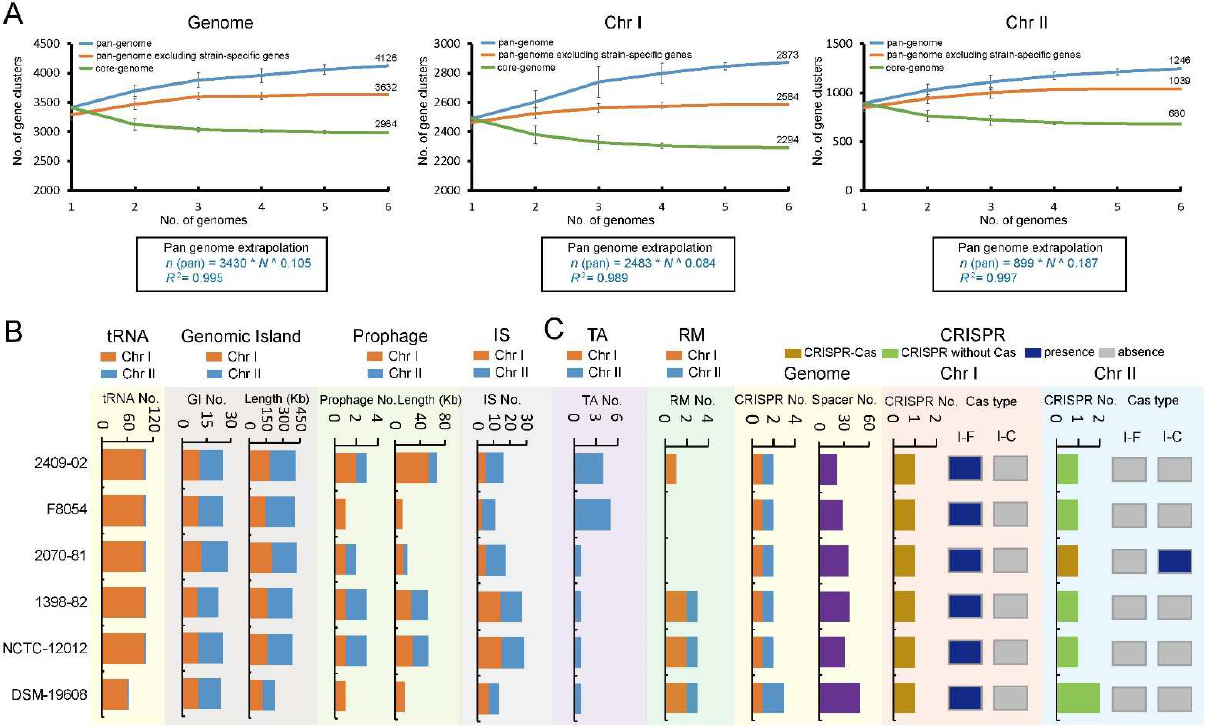
Figure 2. ( A ) The progressive curves for the core, pan-genome, and pan-genome excluding strain- specific genes of the V. cincinnatiensis genome, Chr I, and Chr II. The curves showed the downward trend of the core gene families and the upward trend of the pan-gene families with additional genomes. The deduced mathematical functions of pan-genome curves were shown below the curves; ( B ) distribution of mobile genetic elements; ( C ) distribution of multiple barriers to horizontal gene transfer.